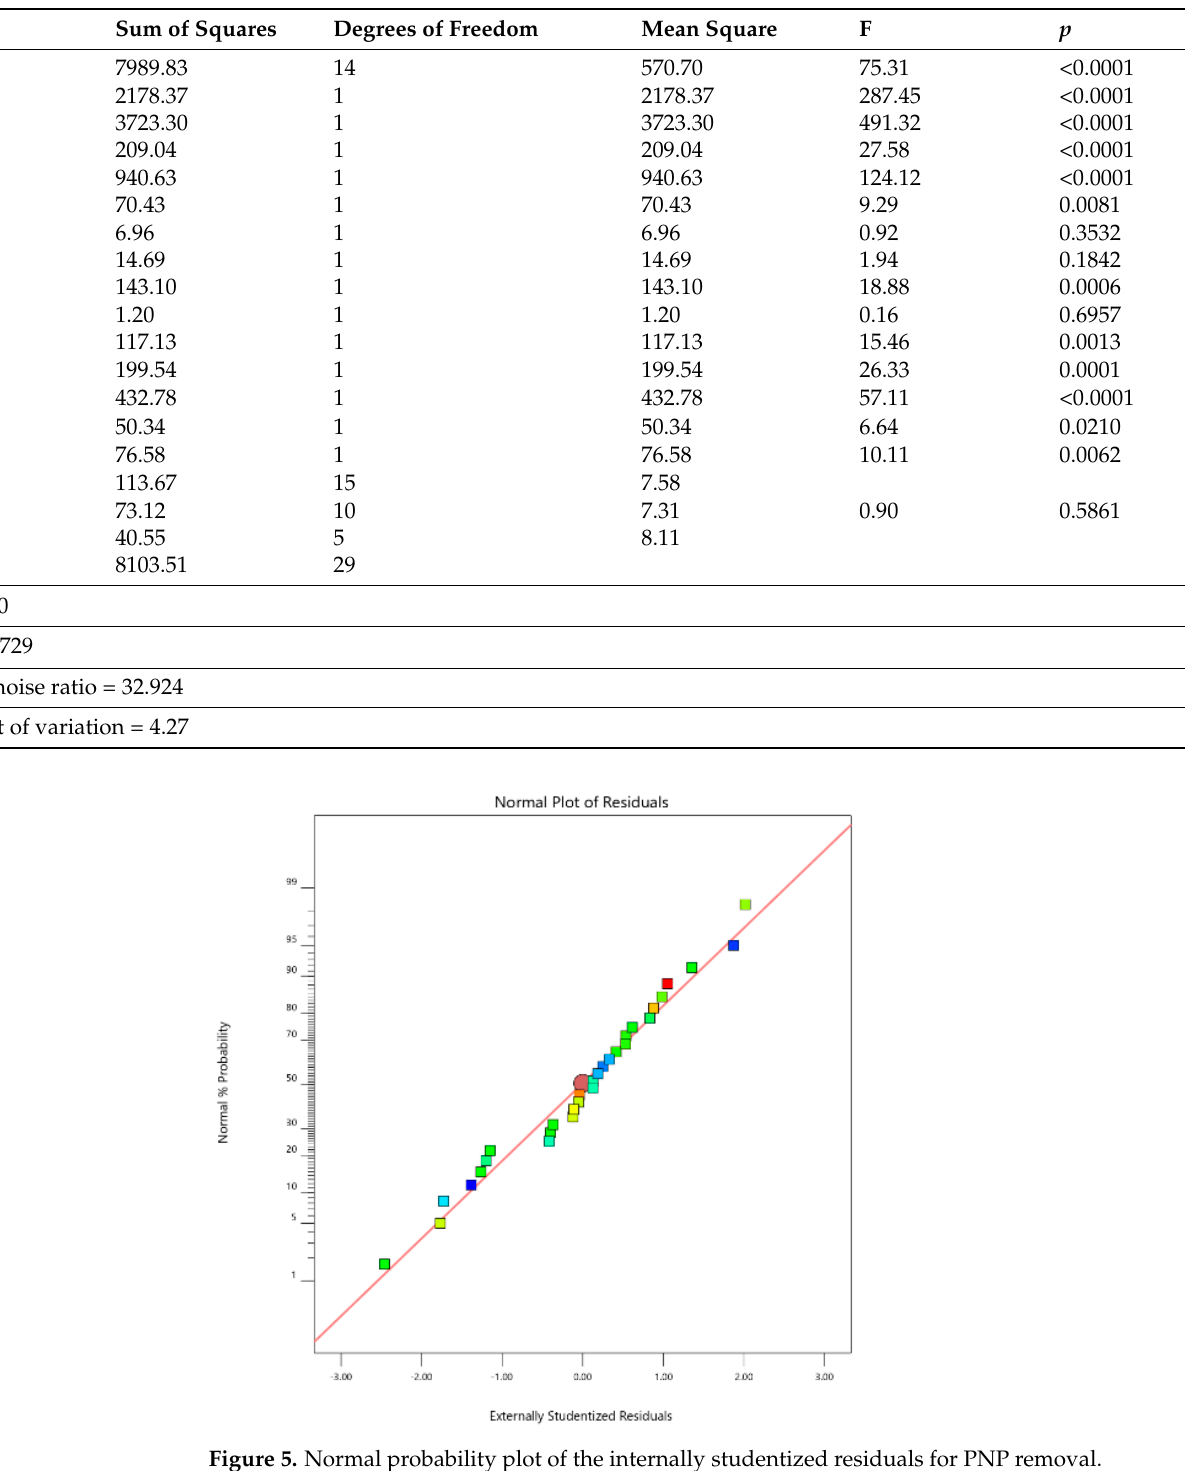
Figure 6. Actual values versus predicted response by CCD. As shown in Table 3, the F-value of the fitted model Fisher’s test was 75.31 with a p - value < 0.0001, indicating that the model was excellent in predicting the PNP degradation efficacy. The misfit value was 0.5861, indicating that the model is reliable and effective. The measured signal-to-noise ratio of the model was 32.924, and the coefficient of varia- tion (CV) was 4.27%, indicating the high accuracy of the experiment. The R 2 values of the fitted model and the adjusted R 2 value were 0.9860 and 0.9729, respectively. The difference between the two values was less than 0.2, indicating the rationality of the model. The p - values for the four factors, Co-nZVI/GAC dosage, PS concentration, UV power, and pH, were all less than 0.0001, indicating that all four elements significantly affected the re- sponse values. The order of significance was PS concentration > Co-nZVI/GAC dosage > pH > UV power. 3.3.2. Response Surface Analysis A three-dimensional response surface and two-dimensional contour map were used to analyze the interaction of the experimental factors with PNP degradation efficiency. Each map shows the interaction between the two factors with the other factors, main- tained at the central level to obtain response surface plots and contour plots of the two factors on the response values. The results are shown in Figures 7 – 10.